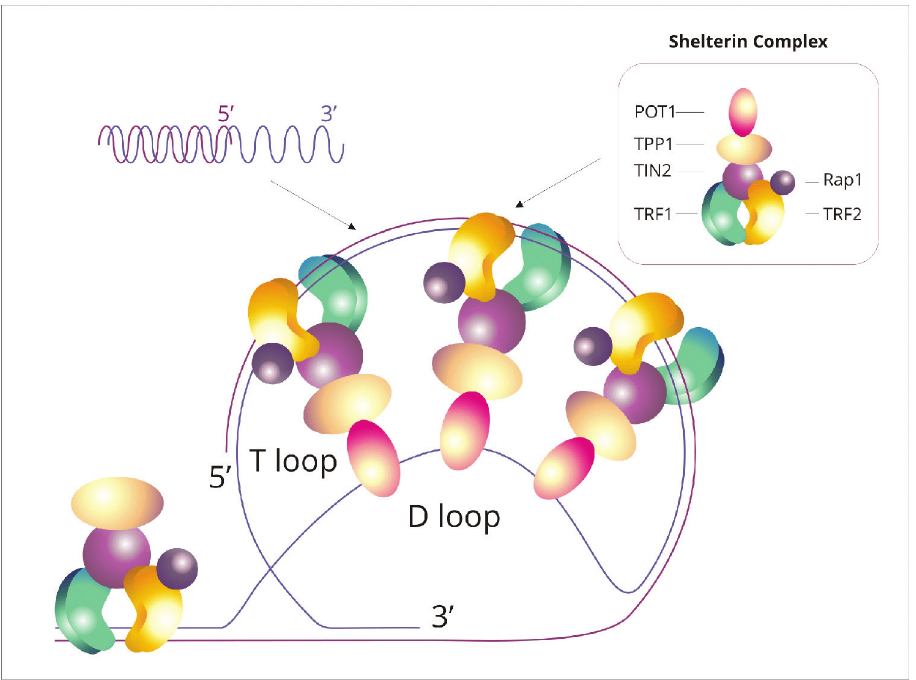
Figure 3. Telomere structure in mammals; T-loop and D-loop are presented together with schematic repre- sentation of the shelterin complex on telomeric DNA. The shelterin complex consists of six proteins: TRF1 and TRF2 (telomere repeat-binding factor 1 and 2), RAP1 (repressor/activator protein 1), TIN2 (TRF1- interacting nuclear factor 2), TPP1 (TINT1/PTOP/PIP1 protein) and POT1 (protection of telomeres